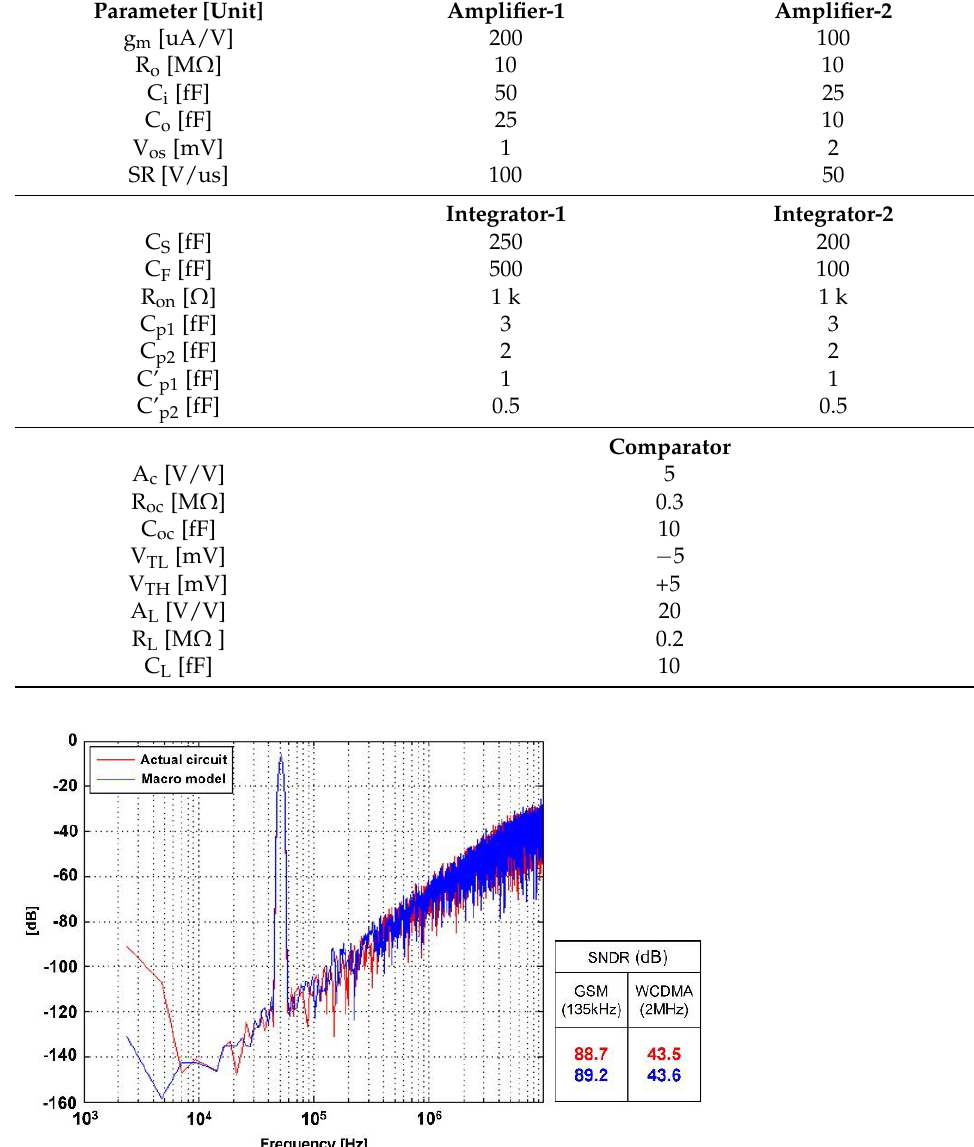
Table 1. Sigma-delta modulator macro model parameter default values.